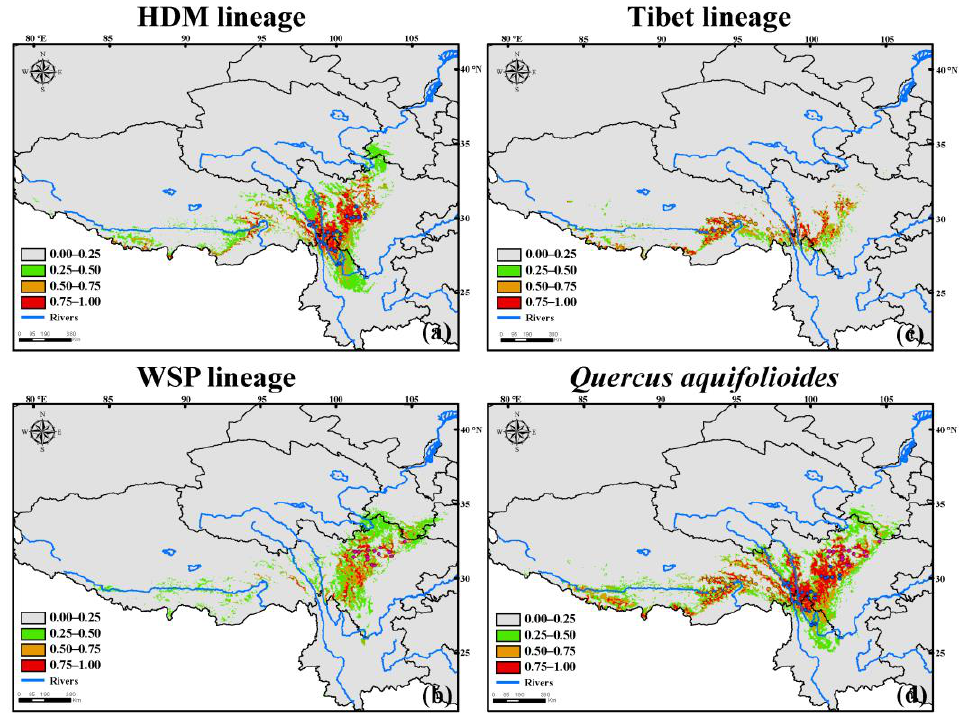
Figure 3. ENMs’ results of ( a – c ) the three intraspecific lineages of Quercus aquifolioides and ( d ) this species at contemporary climatic conditions.